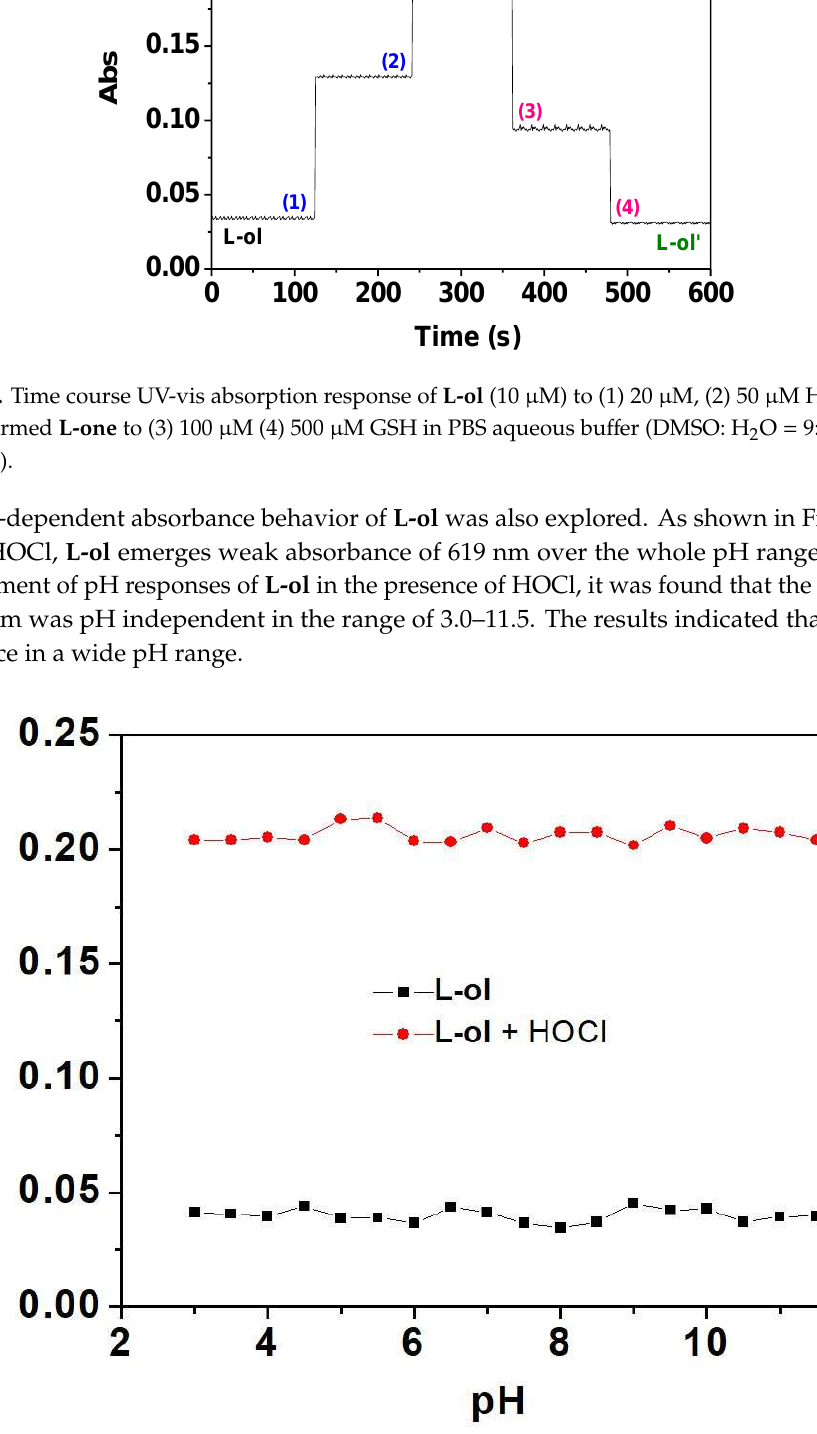
Figure 8. E ff ect of pH on the absorbance of L-ol (10 µ M) at 619 nm in the absence and presence of Figure 8. Effect of pH on the absorbance of L-ol (10 μM) at 619 nm in the absence and presence of HOCl (50 µ HOCl (50 μM).